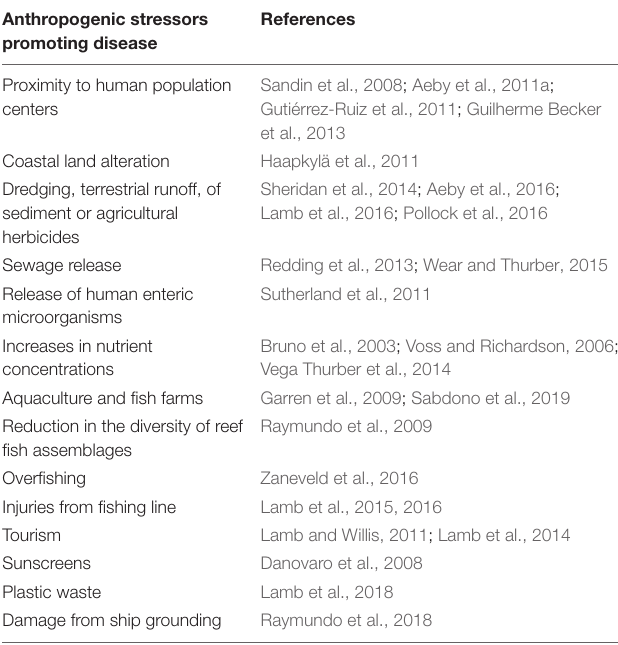
TABLE 3 | Anthropogenic factors associated with increased coral disease